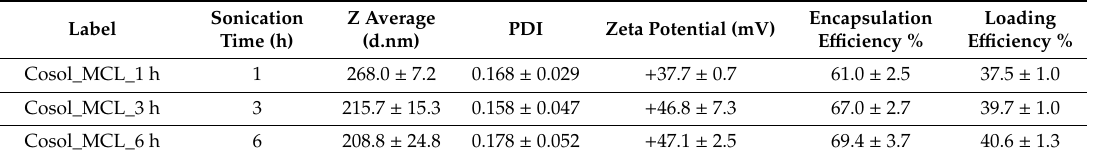
Table 3. Characterizations of MCLs by the cosolvent sonication method for di ff erent sonication times.